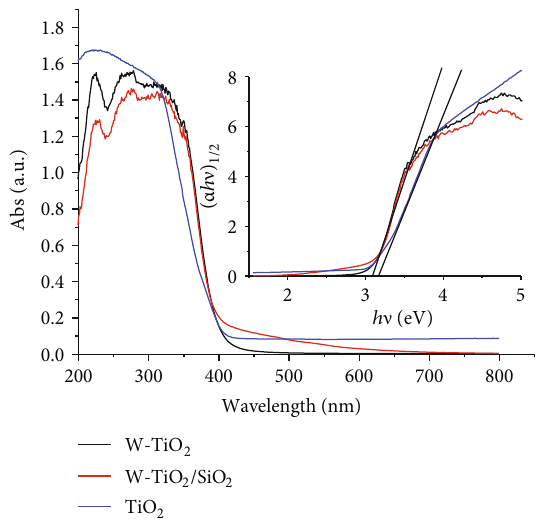
Figure 2: DRS-UV-vis spectra and Kubelka-Munk function versus energy ( h ν ) plots for the TiO